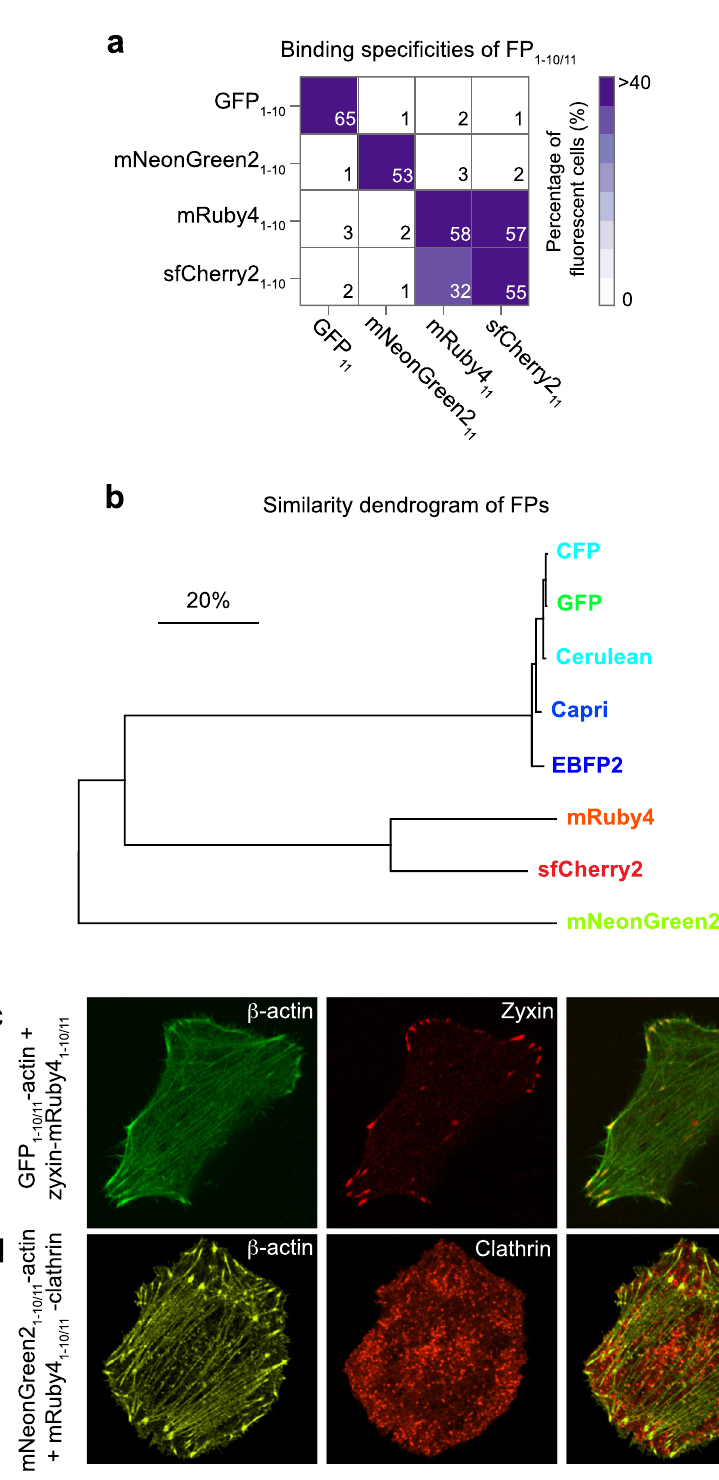
Fig. 3 Characterizing the binding speci fi cities of available FP 1-10/11 pairs. a Characterizing the binding speci fi cities of GFP 1-10/11 , sfCherry2 1-10/11 , mNeonGreen2 1-10/11 , and mRuby4 1-10/11 by fl ow cytometry (see also Supplementary Fig. 15). Each of the FP 11 fragments was tested for complementation to all of the FP 1-10 fragments. Complementation is indicated as the percentage of fl uorescent cells by a color scale and the number in each block. b , c Dual- color fl uorescence images of HeLa cells expressing GFP 1-10/11 - β -actin and Zyxin-mRuby4 1-10/11 ( b ), and mNeonGreen2 1-10/11 - β -actin and mRuby4 1-10/11 - Clathrin ( c ). d This dendrogram is based on the similarities of the following fl uorescence protein sequences: EBFP2, Capri, Cerulean, CFP, GFP, mNeonGreen2, mRuby4, and sfCherry2. Proteins that share sequences are separated by smaller branch lengths. Scale bar, 20% dissimilarity. The dendrogram was constructed using MEGA 7.0 software. Scale bars, 10 μ